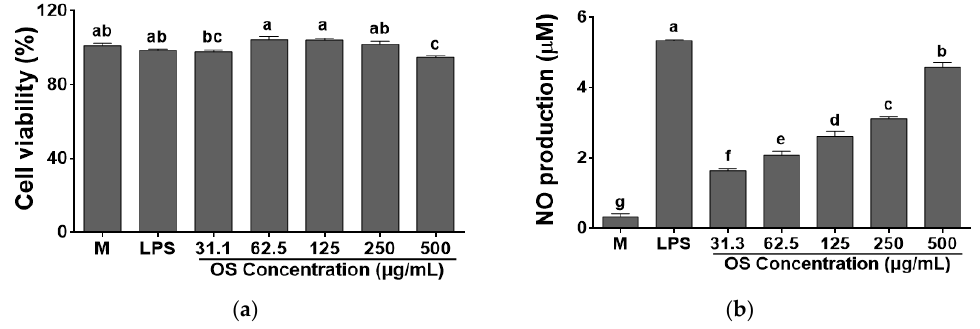
Figure 4. Effects of A. cepa skin (OS) extracts on ( a ) cell viability and (b) the nitric oxide (NO) production by RAW 264.7 cells. Data was expressed as the mean ± SEM. a–g Different letters on bars are significantly different at p < 0.05.